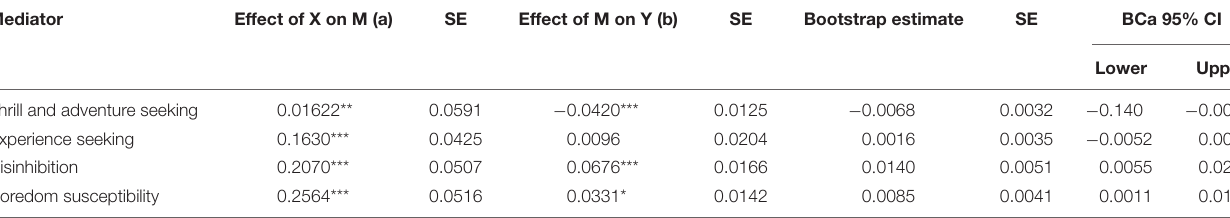
TABLE 2 | Indirect effect of dysfunctional impulsivity on smartphone abuse through sensation seeking